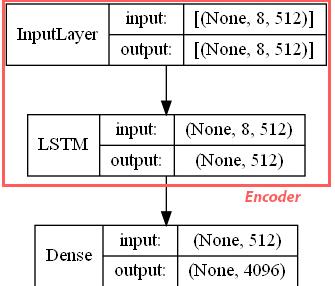
Figure A3. The LSTM auto-encoder.